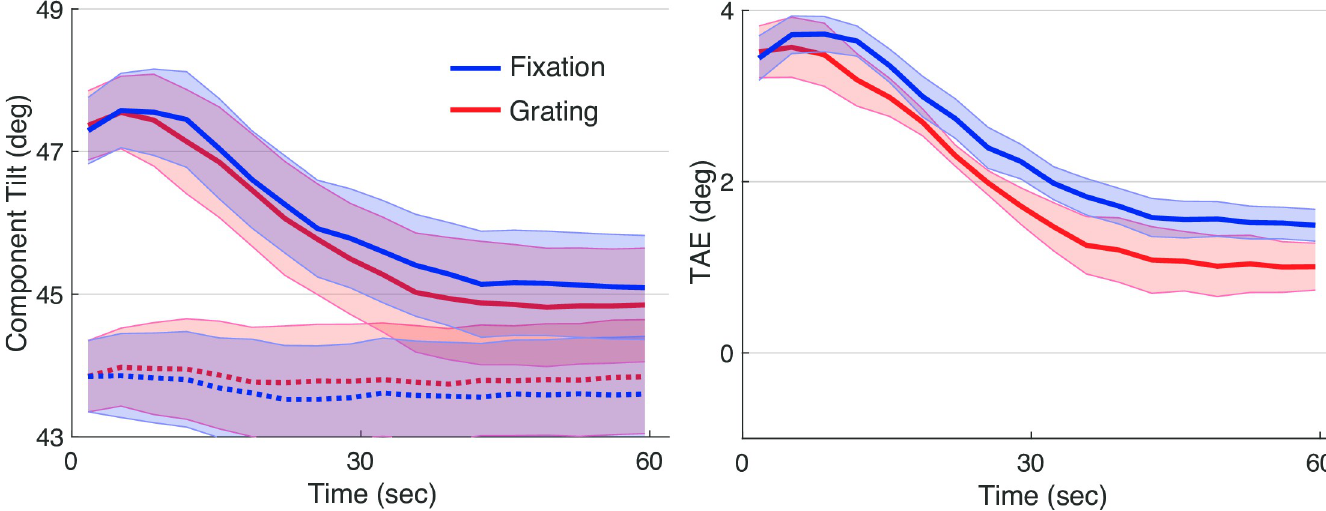
Fig 7. Results of experiment 2. The left panel shows results of the TAE Task, when interleaved with the Grating Task (red) and with the Fixation Task (blue), before (dotted) and after adaptation (solid). The right panel shows effects of adaptation computed by subtracting baseline TAE from TAE after adaptation, for each secondary task, separately. Lines plot means across participants and error ribbons indicate +/- one standard error of the mean.